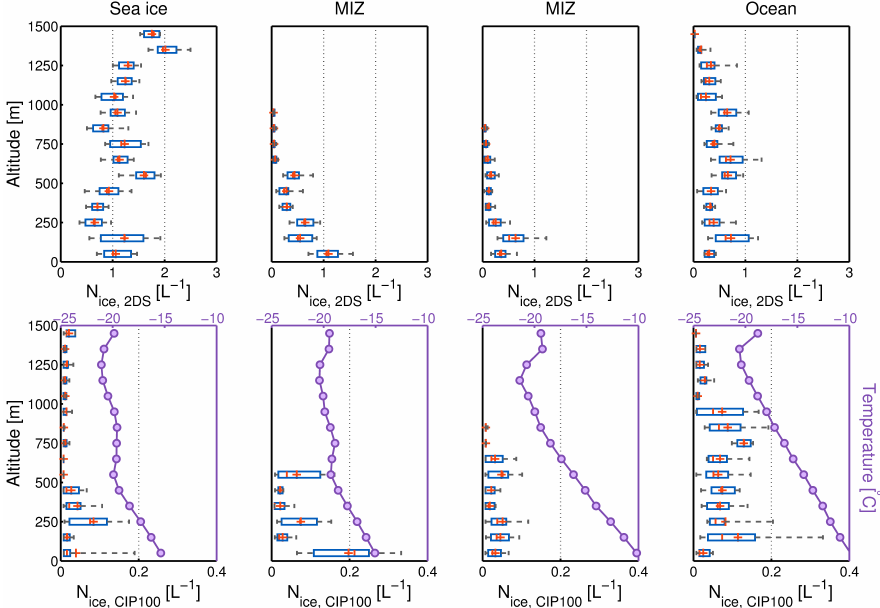
Figure 13. Ice number concentrations (L − 1 ) from the 2DS and CIP100 over the transition region. Data are displayed similarly to Fig. 12. Temperature is overlaid (purple) in the bottom